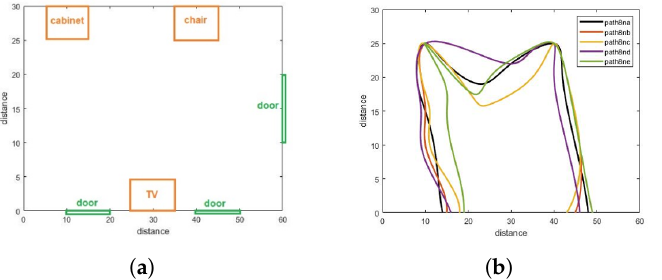
Figure 2. Walking paths in different observation for normal pattern. ( a ) The living room. ( b ) Multi- paths for one pattern